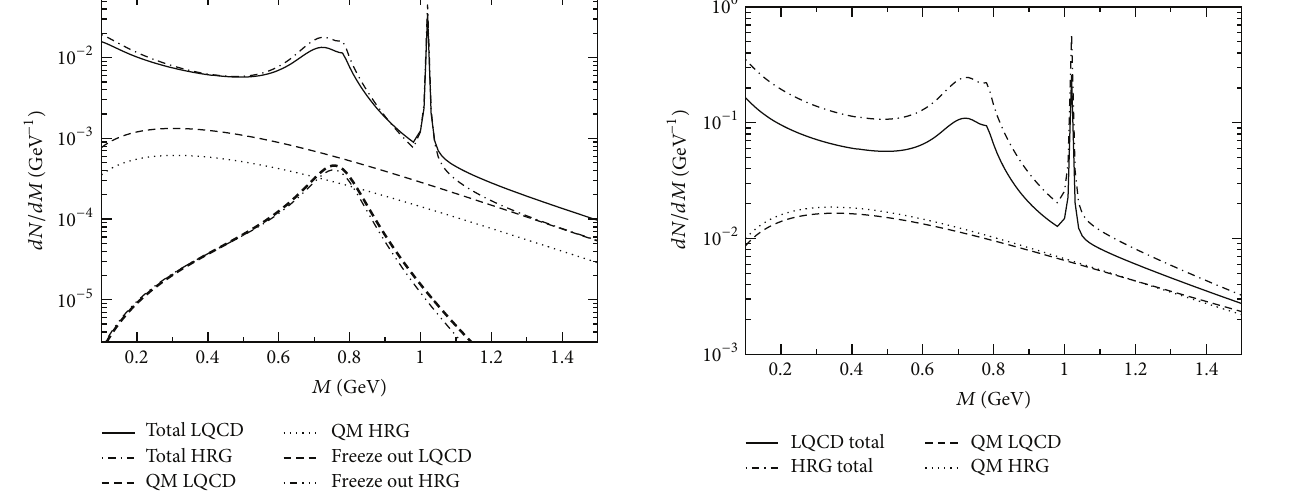
Figure 25: Freeze-out, QGP, and total contribution for EoS (a) HRG (dash-double dotted, dotted, and dash-dotted lines) and EoS (b) LQCD (bold dashed, dashed, and solid lines) at RHIC energy.